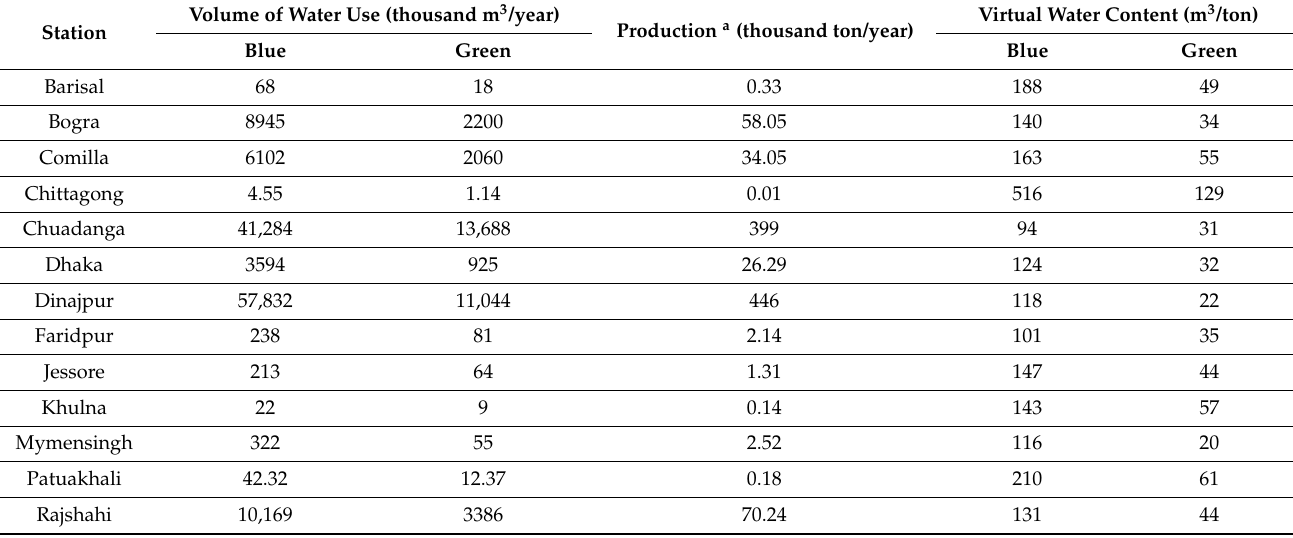
Table A5. Blue water footprint and green water footprint of maize in